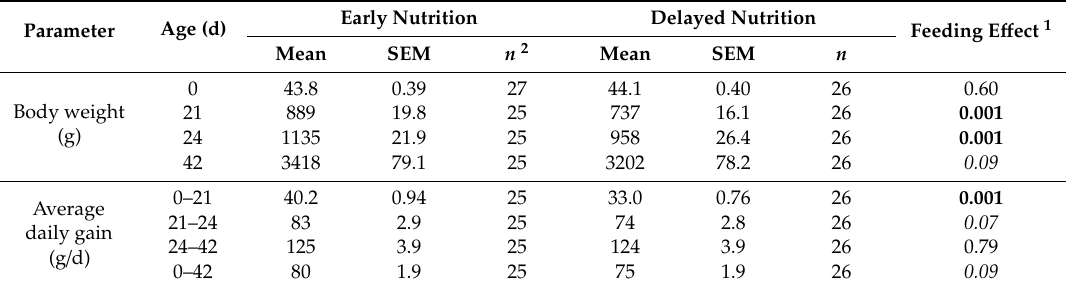
Table 2. Body weight and average daily gain (ADG) of broiler chickens receiving either delayed or early nutrition in experiment I. Data are presented as estimated marginal means with standard errors